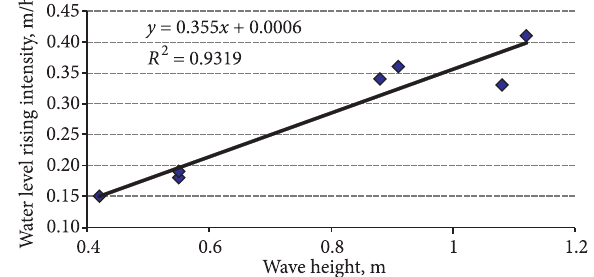
Fig. 6. Relationship between the height of the flux wave induced by the HPP and the water level rising